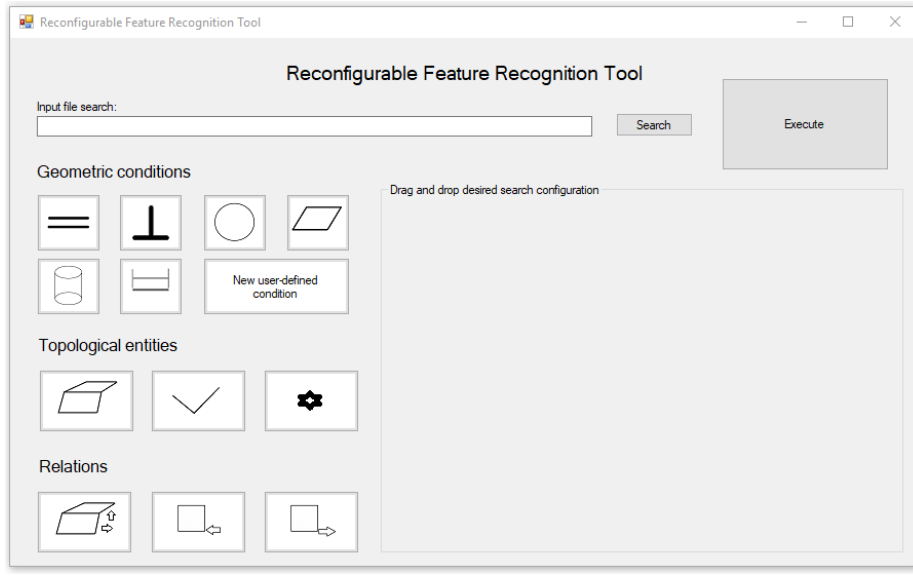
Figure 11. Tool’s Graphic User